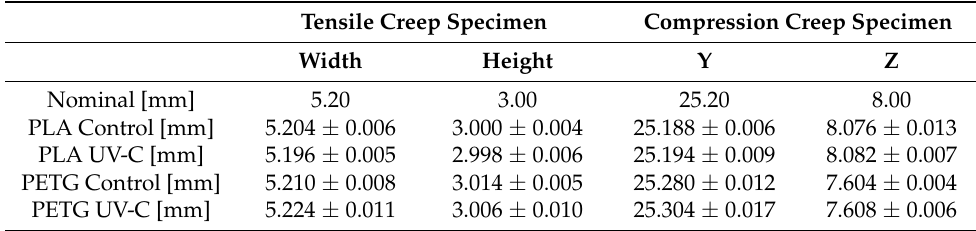
Table 2. Dimensional measurements.